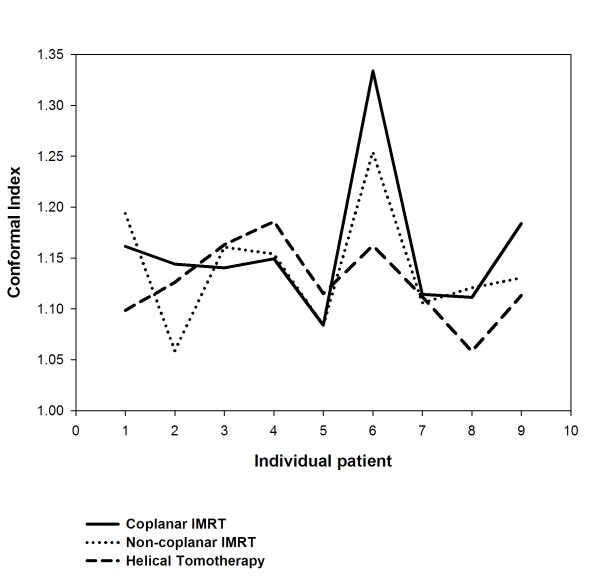
The conformal index (CI) for each individual patient undergoing coplanar intensity-modulated radiotherapy (IMRT), noncoplanar IMRT, and helical tomotherapy.